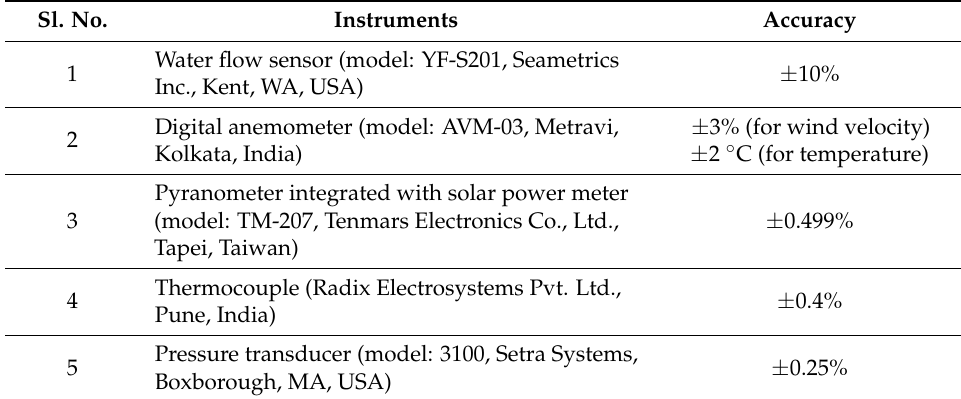
Table 2. Accuracies of the